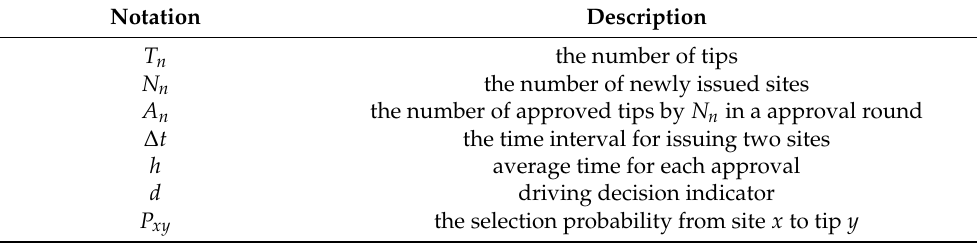
Table 1. The Main